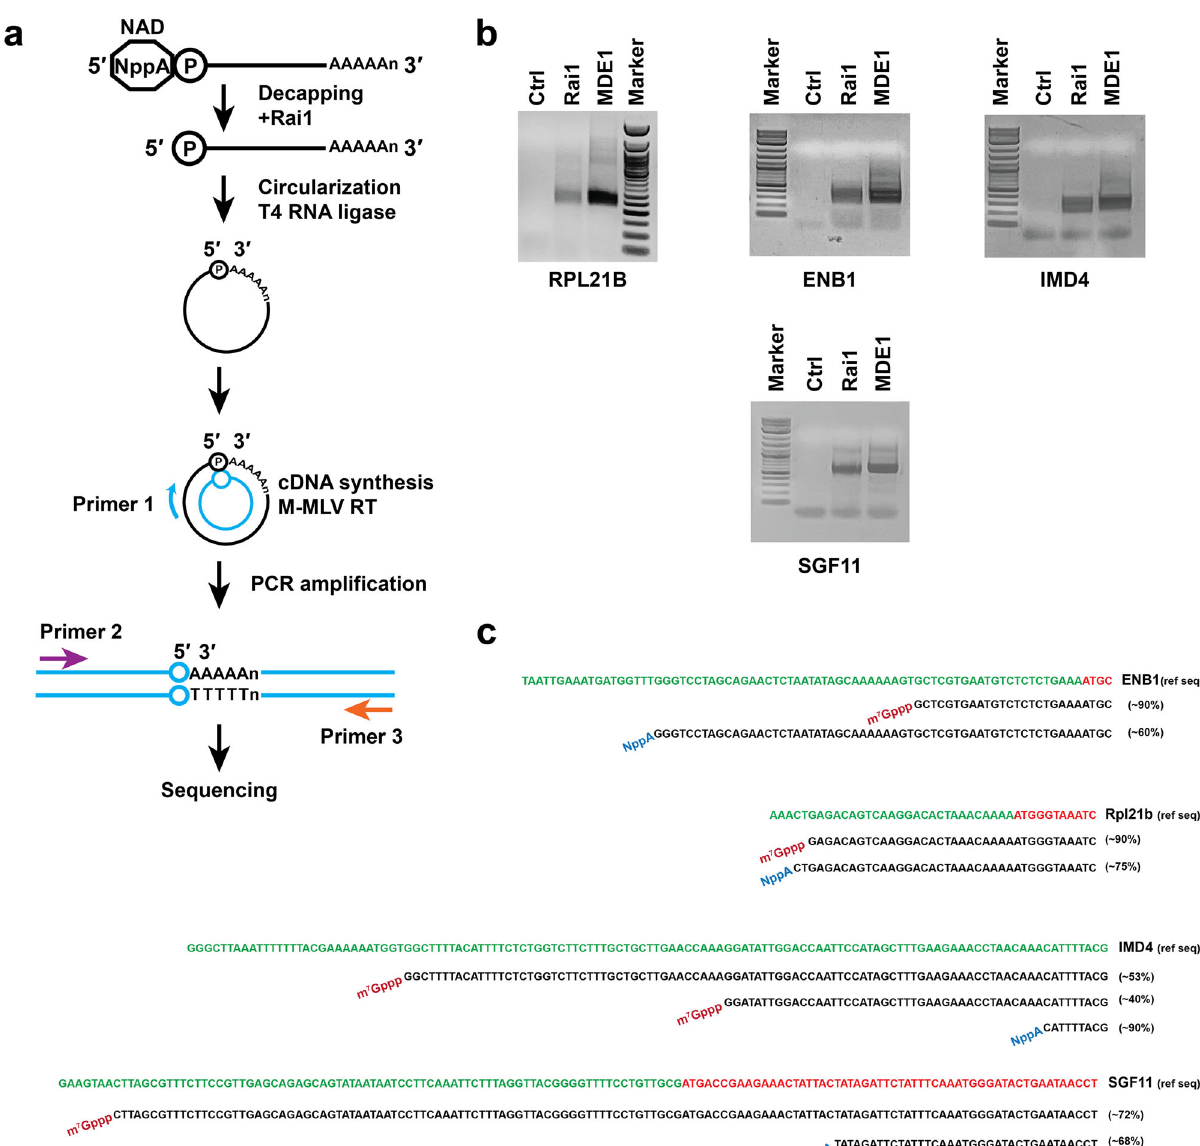
Fig. 4 circNC as an orthogonal method for non-canonical-capped RNA detection. a Schematic illustration of the circNC method. b Transcript-speci fi c PCR of validated NAD-capped RNAs subjected to circularization following Rai1 treatment (NAD-RNA) or MDE treatment (m 7 G-RNA) as illustrated in ( a ) and resolved on 2% TAE-agarose gel. c Sequence alignment of the Rai1 and MDE-treated samples derived from next-generation sequencing of the PCR products generated from the nuclear-encoded transcripts are shown. The alignment represents the most prevalent annotated reads spanning the 5 ′ -3 ′ junction. The percentage of reads corresponding to the depicted sequences are shown on the right of each sequence. The green color of the reference sequence represents the 5 ′ UTR while the red region denotes the open reading frame starting with the ATG initiation methionine